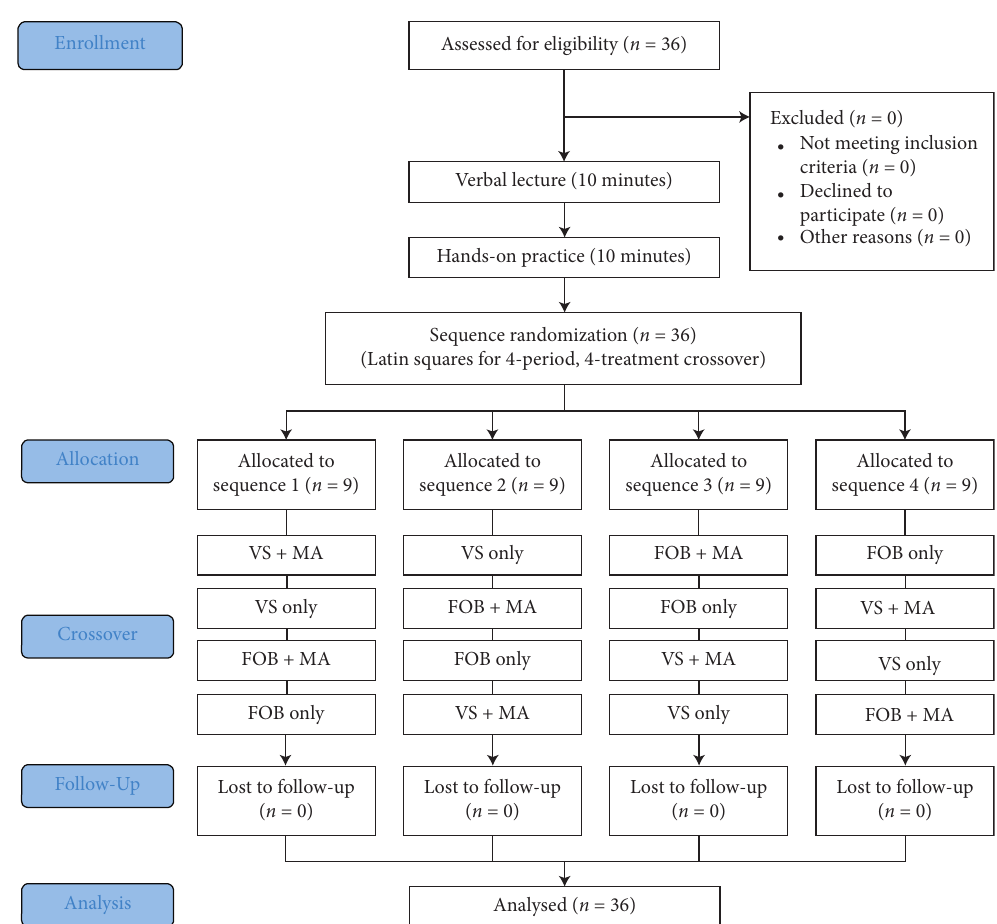
Figure 1: Flow diagram of the study. FOB: fiberoptic bronchoscope; VS: video stylet; MA: modified